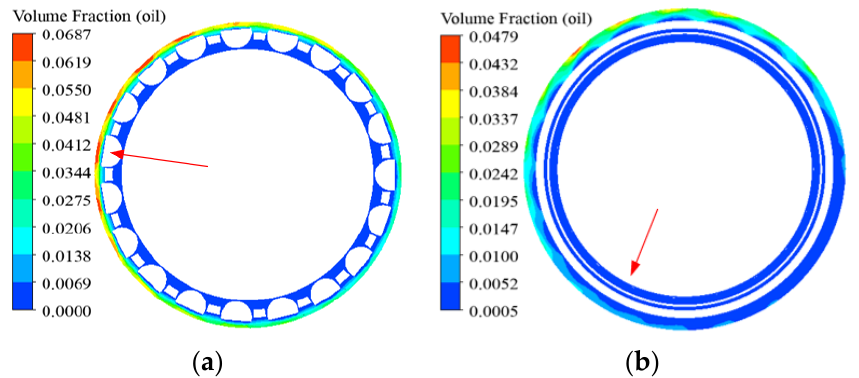
Figure 18. Lubricating oil distribution at the large roller ribs of the bearing. ( a ) Outer ring rib structure; ( b ) Inner ring rib structure.